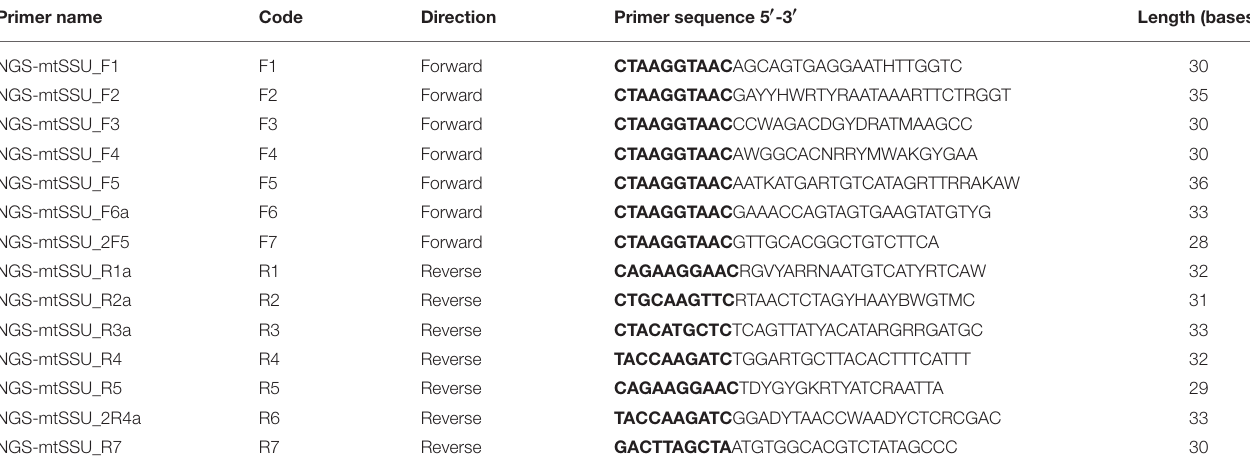
TABLE 2 | Primer sequences used for the two-stage, nested multiplex PCR protocol.